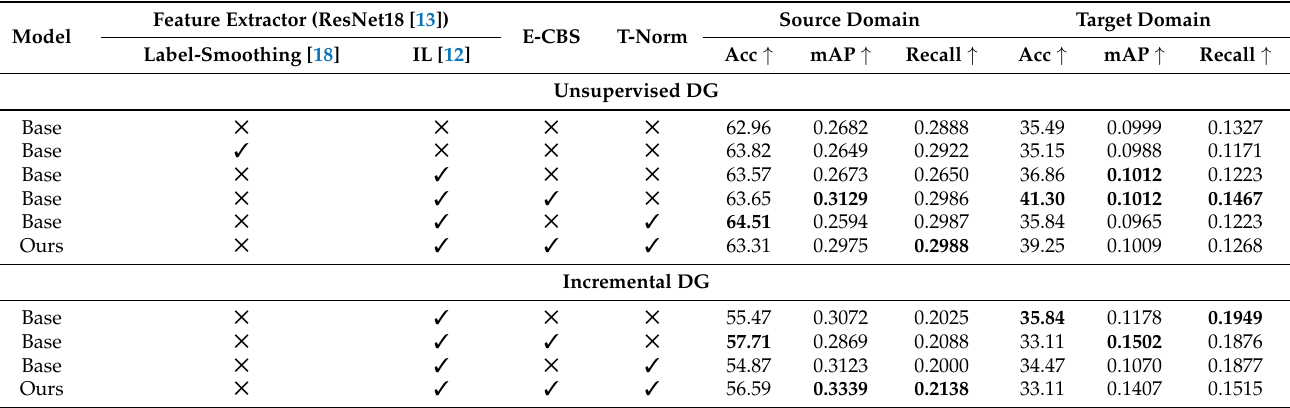
Table 3. Ablation study of our proposed model trained using unsupervised DG and incremental DG in instrument–tissue interaction detection in the source and target domains. Model